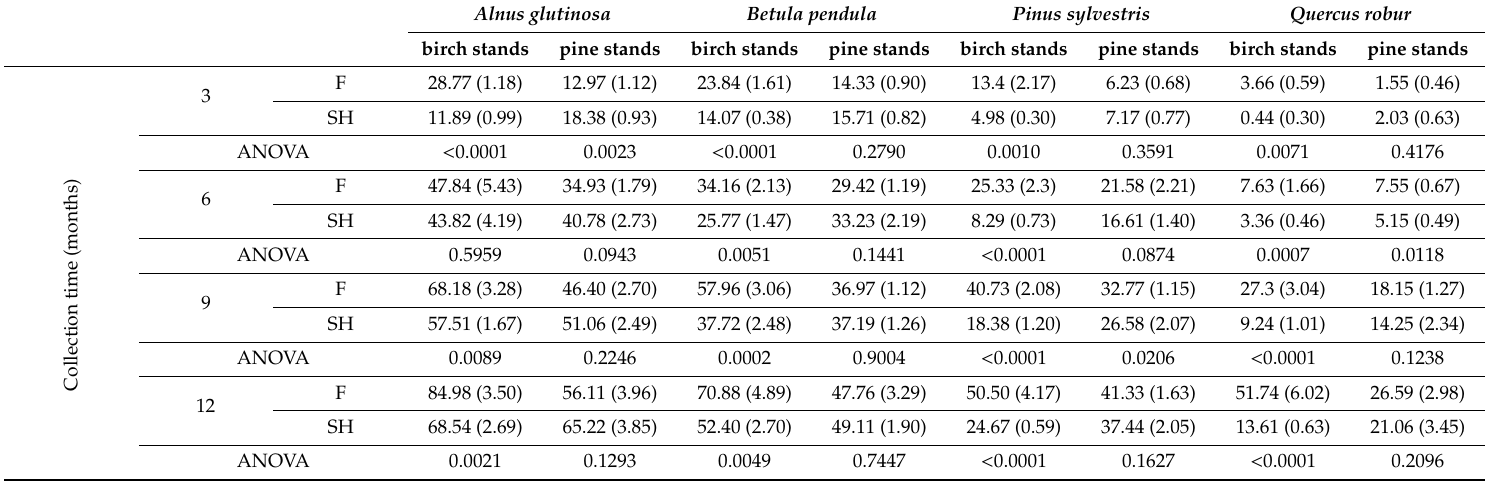
Table A3. Average mass loss (%, ± SE) of particular tree species leaf litter at every collection time in two di ff erent site and stand types. ANOVA was performed to examine the influence of site type on leaf litter decomposition rates for every litter type at every collection time. Abbreviations: SH—spoil heap; F—forest